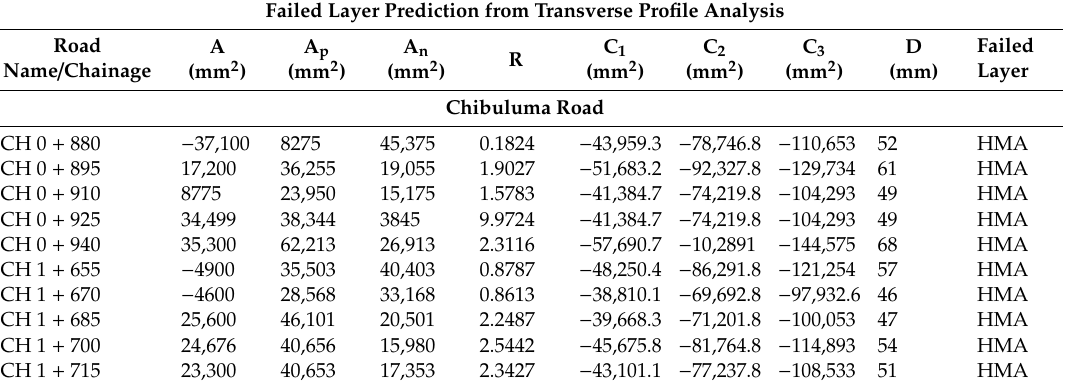
Table 4. Chibuluma Road profile analysis.